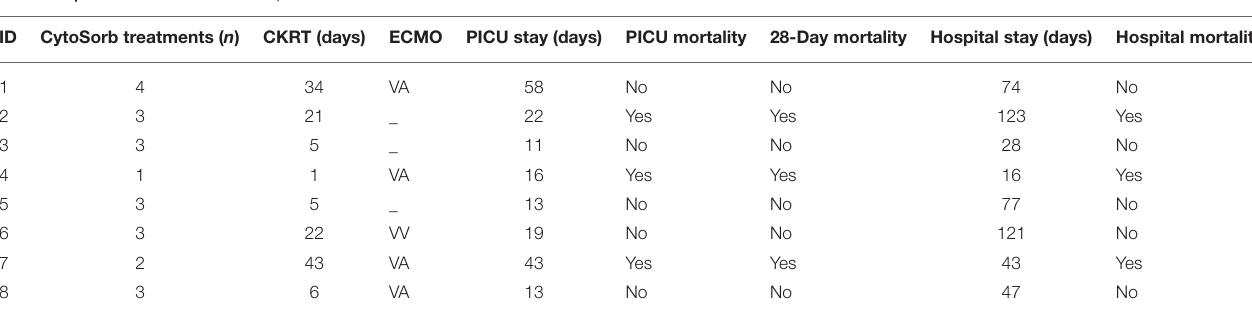
TABLE 3 | Treatment modalities and patients’ clinical